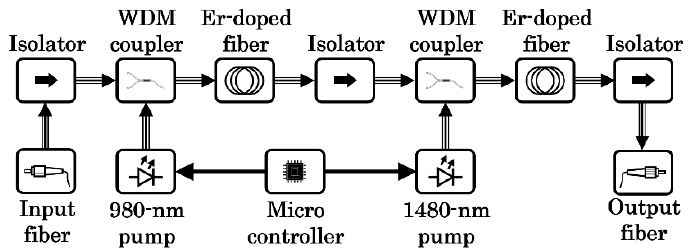
Figure 3. Block diagram of the 2-W CubeSat’s EDFA.